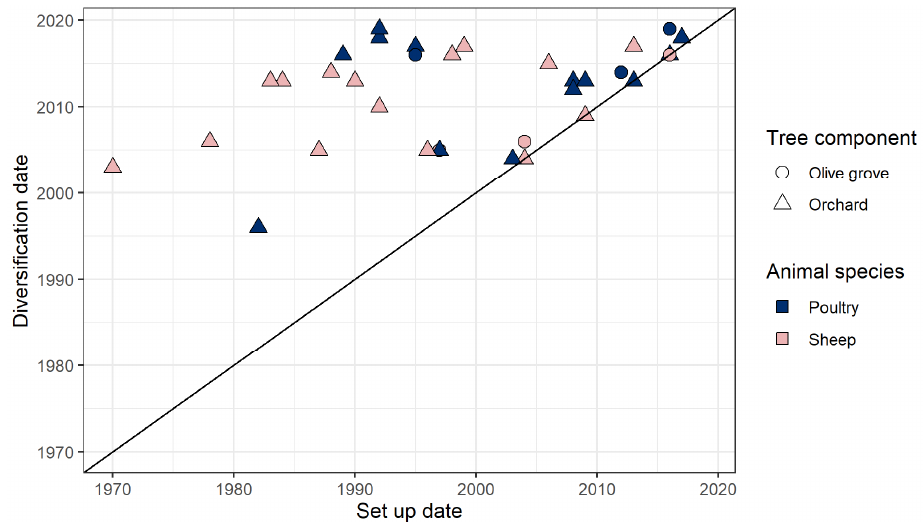
Figure 2. Diversification date as a function of set-up date, livestock species, and orchard type. Points on the bisector represent grazed orchards designed at the set-up date; the points far from the bisector represent diversification trajectories that took place after the set-up date.